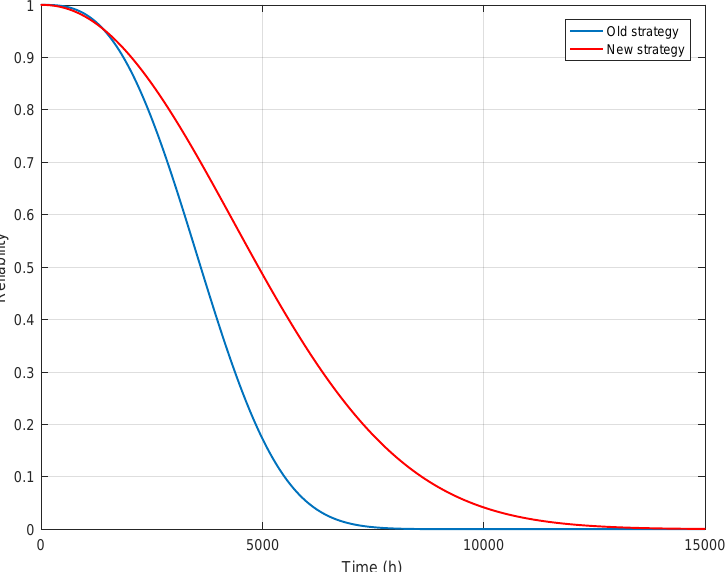
Figure 7. Comparison of the reliability value of coal mills with the (“new strategy”) and without the (“old strategy”) performing remediation